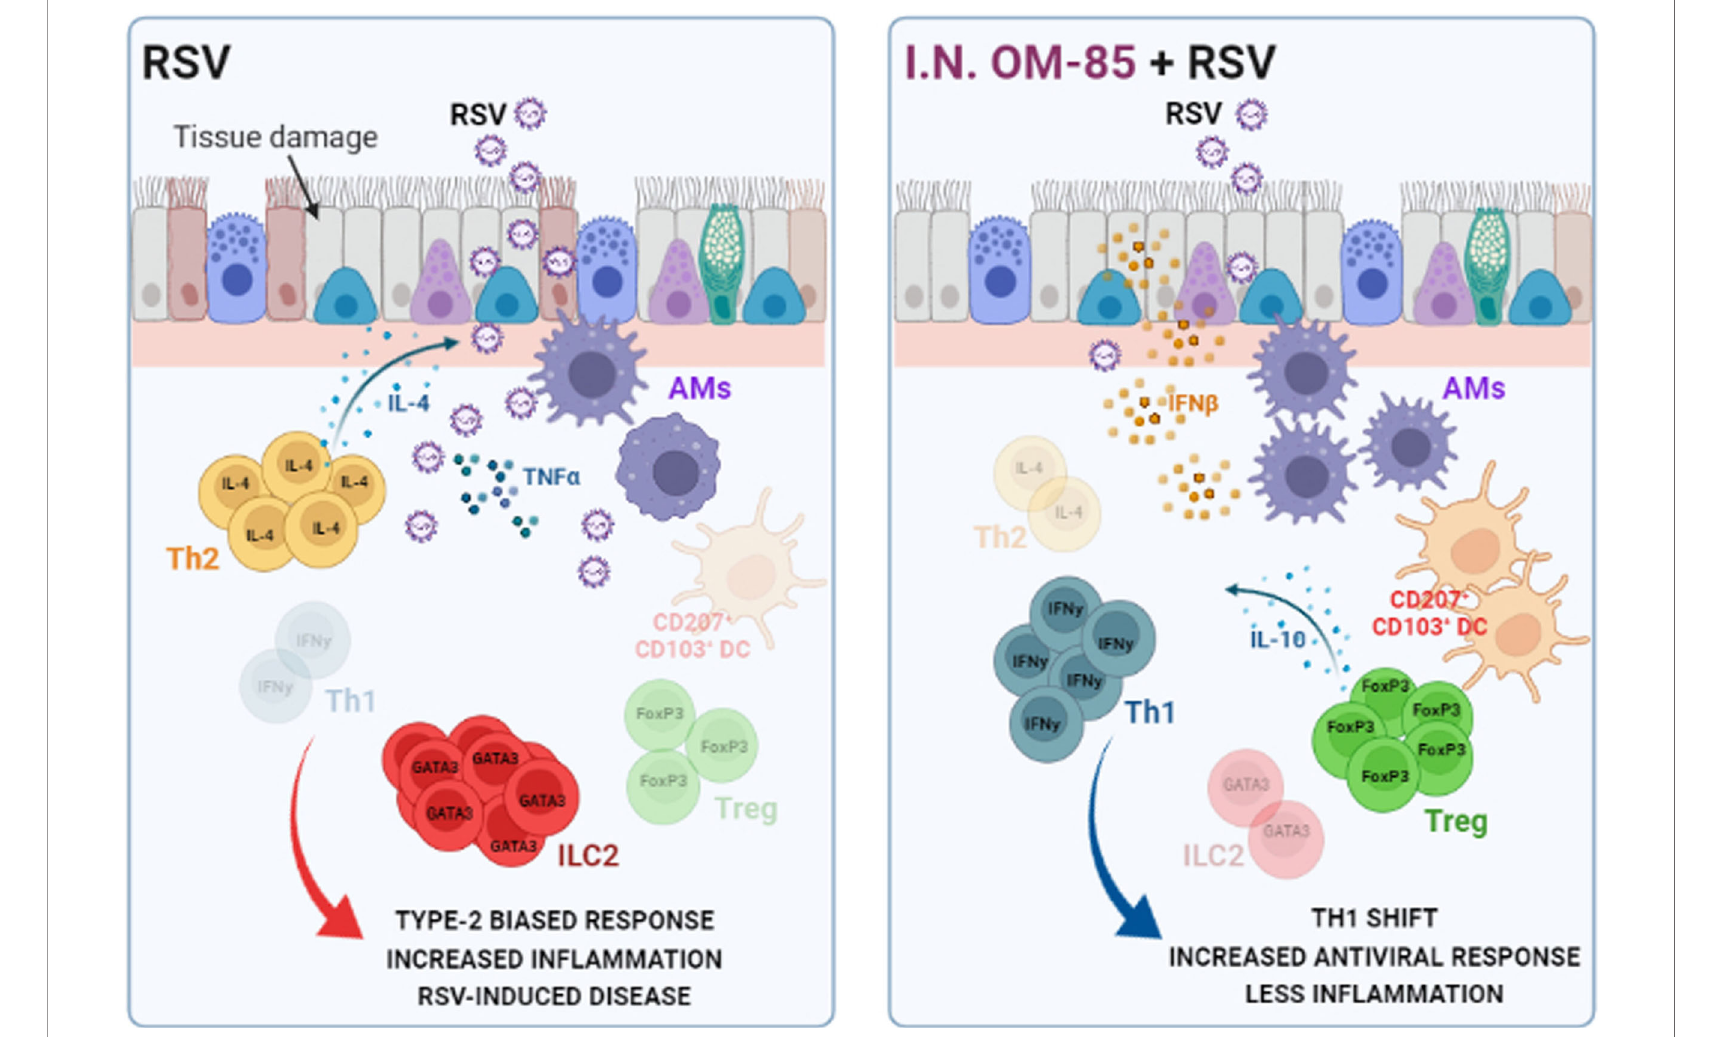
FIGURE 9 | Preventive effects of airway – delivered OM – 85 during RSV infection. Preventive treatment with OM – 85 directly delivered into the airways promote a pro – resolutive homeostatic environment in the lung mucosa, increasing alveolar macrophages, tolerogenic DCs, Treg, and Th1 cell population in locus. This pro fi le enhances viral clearance, increasing IFN b production, preventing Th2 – biased response and ILC2 – caused hyperresponsiveness in the lung, ameliorating RSV – induced disease. Image created with